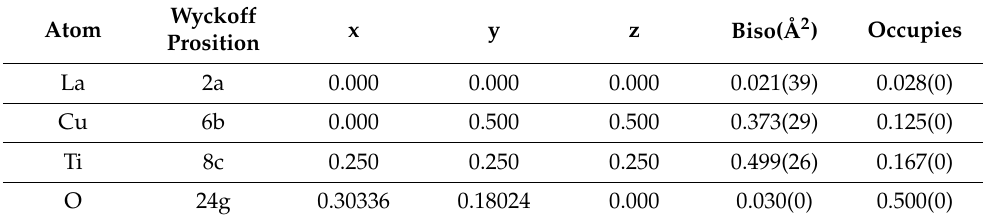
Figure 2. XRD pattern with Rietveld analysis of La 2/3 Cu 3 Ti 4 O 12 ceramics: Y obs is experiment data. Y cal is the calculation results. Two short vertical lines below represent La 2/3 Cu 3 Ti 4 O 12 ceramics and a minor amount of second phase TiO 2 (1.39 wt %), respectively. Table 1. Structure Parameters for La 2/3 Cu 3 Ti 4 O 12 ceramics.